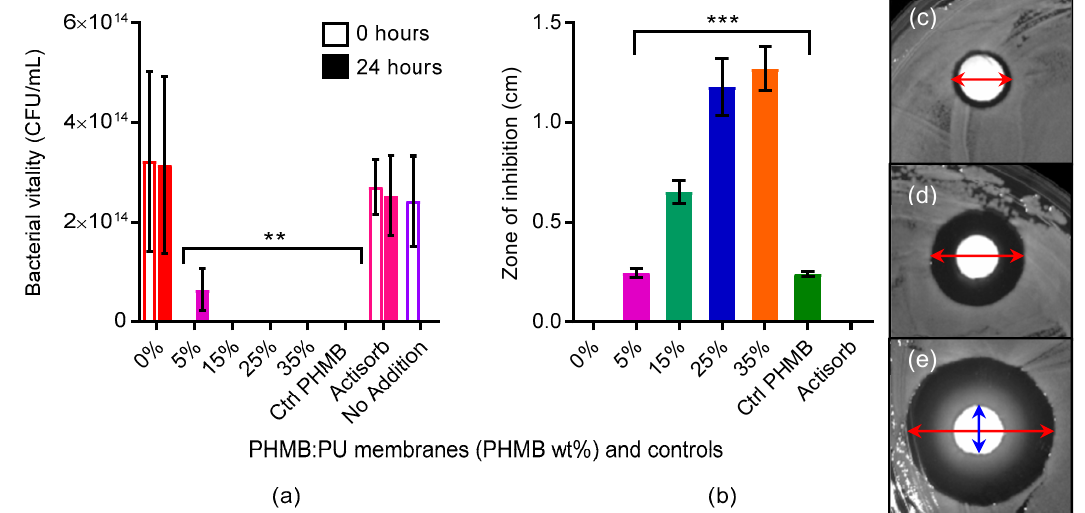
Figure 8. Antibacterial activities of PHMB:PU membranes. ( a ) Antimicrobial activity in liquid S.aureus RN4220 cultures. Surviving bacterial colony forming units (CFU / mL) after overnight incubation